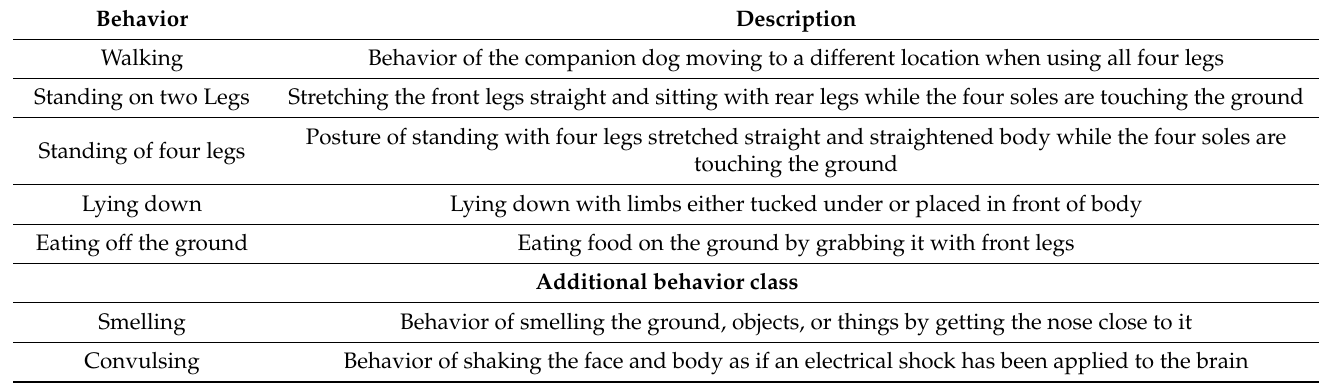
Table 2. Definitions of categories in dog